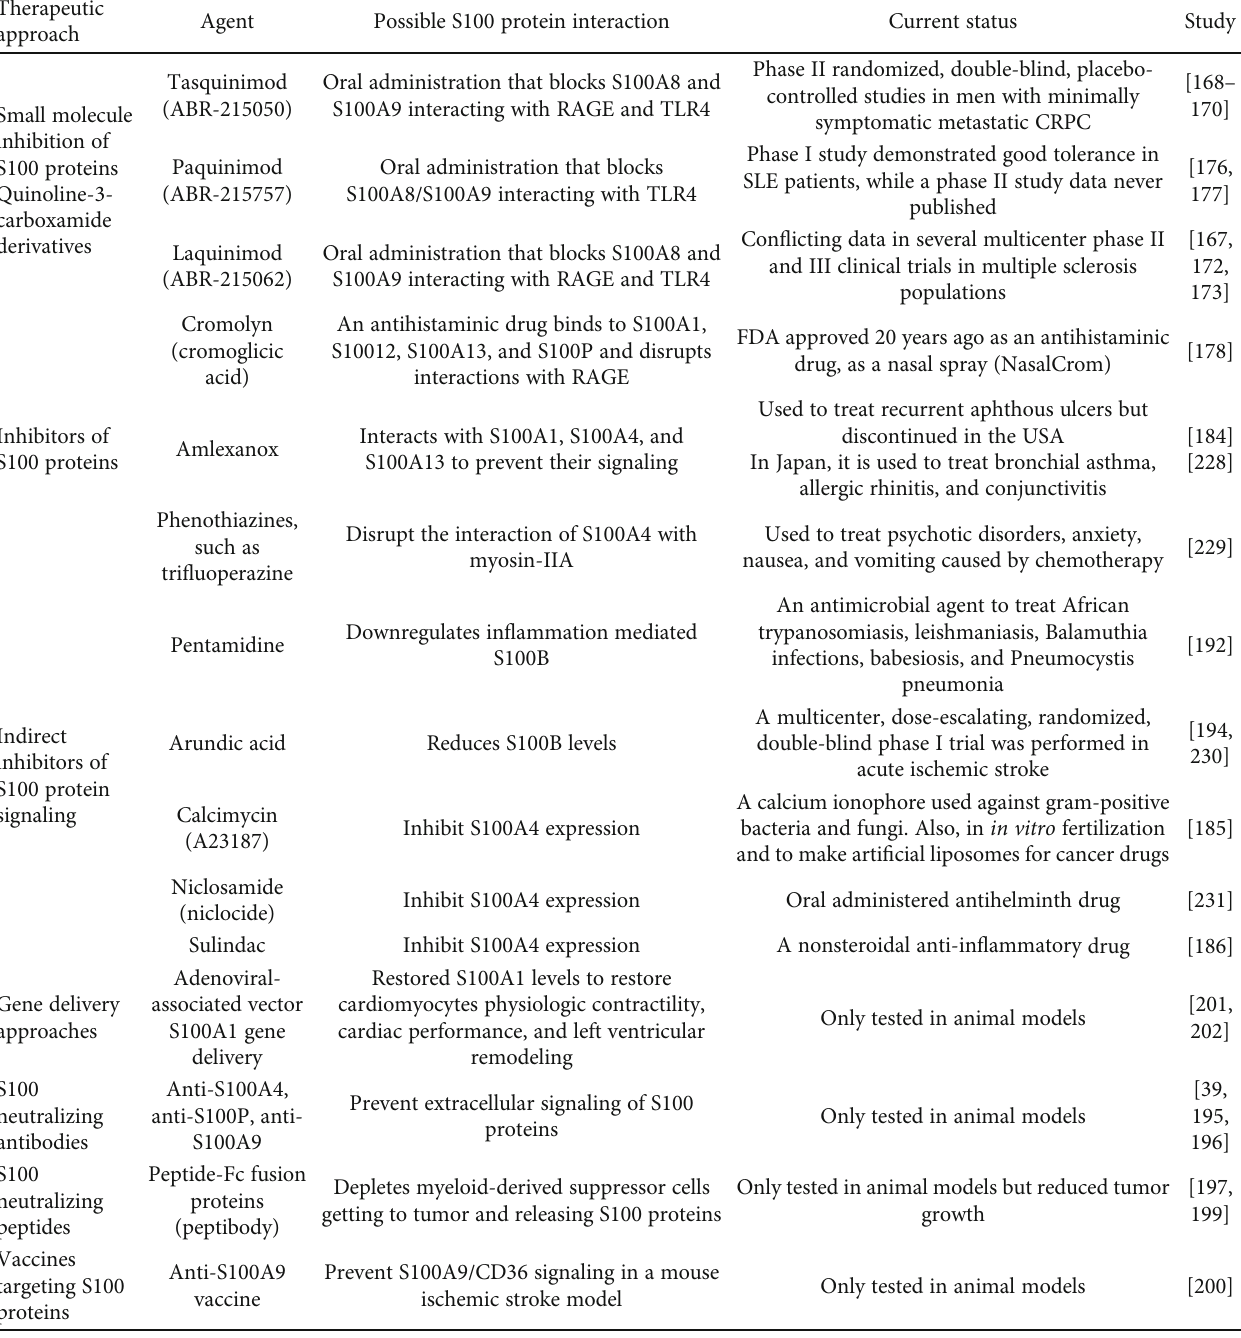
Table 2: Current drug development targeting S100